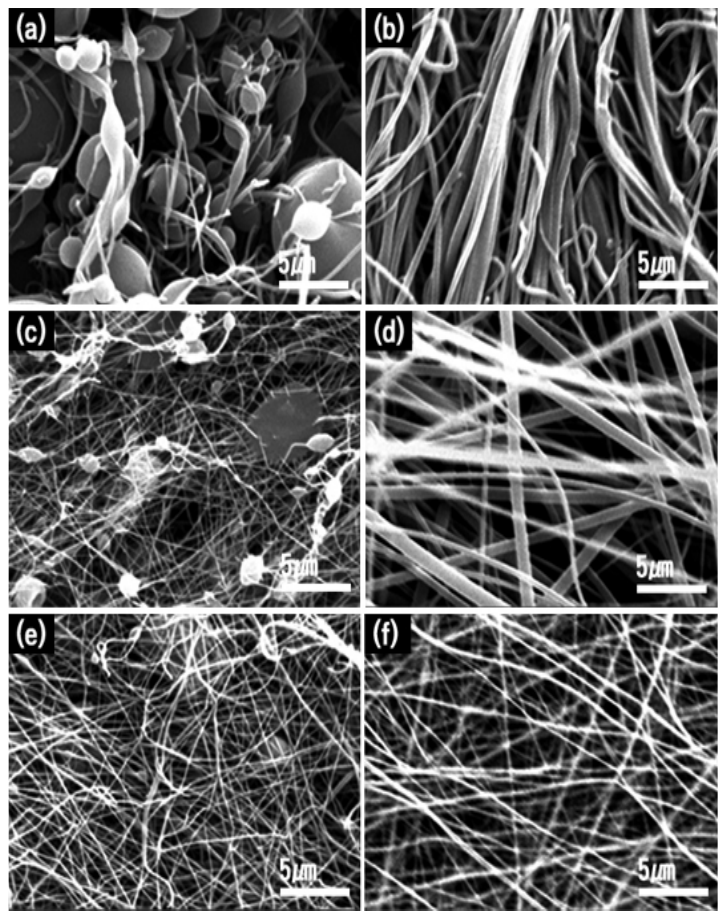
Figure 1. FESEM images of electrospun samples; ( a ) S1, ( b ) S2, ( c ) S3, ( d ) S4, ( e ) S5, ( f )